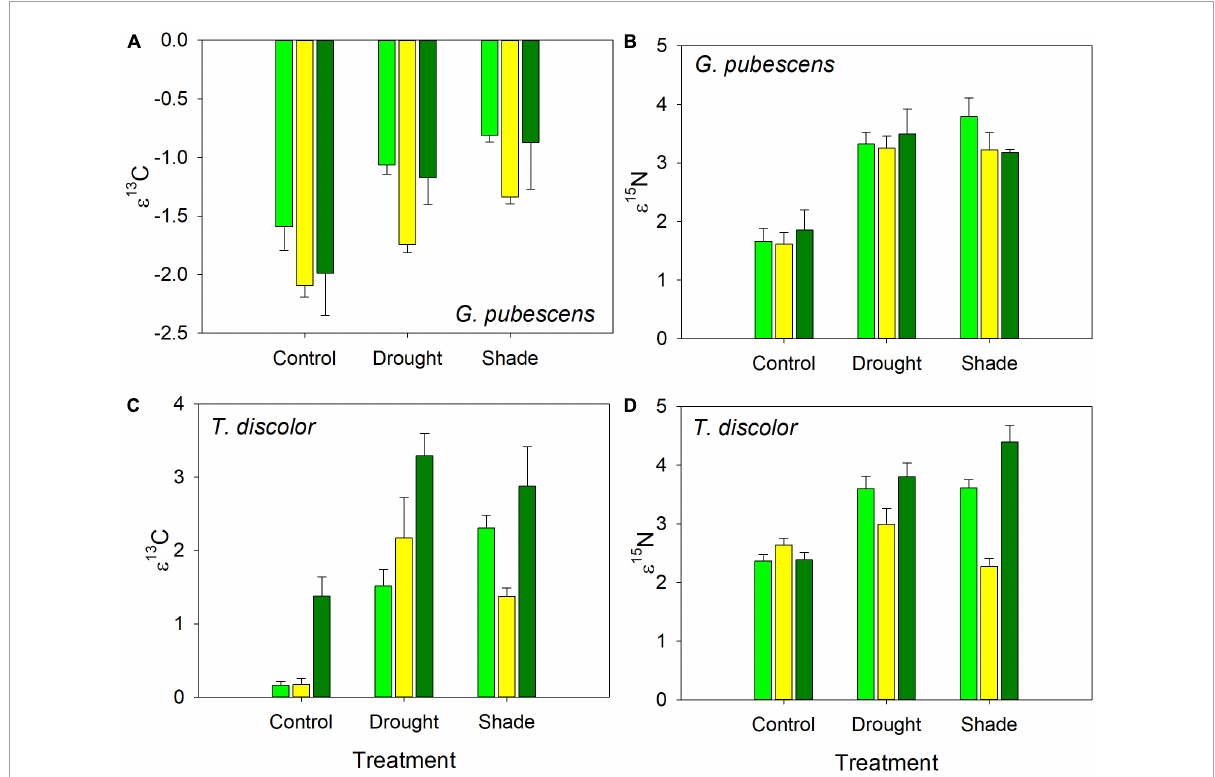
FIGURE3 Isotopic enrichment factors for 13 C and 15 N for G. pubescens (A,B) and T. discolor (C,D) exposed to control, drought, and shade treatments. Mean enrichment factor ± se is shown. Different colored bars indicate different sites.